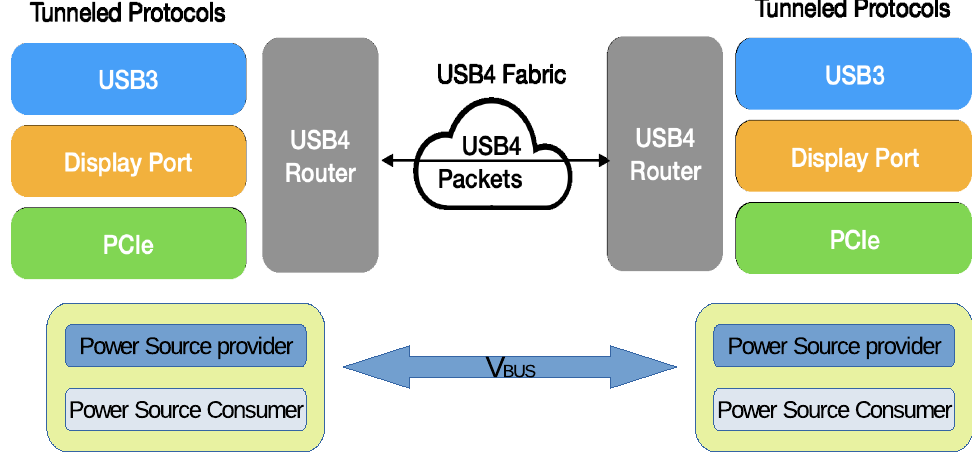
Figure 7. USB 4 protocol topology